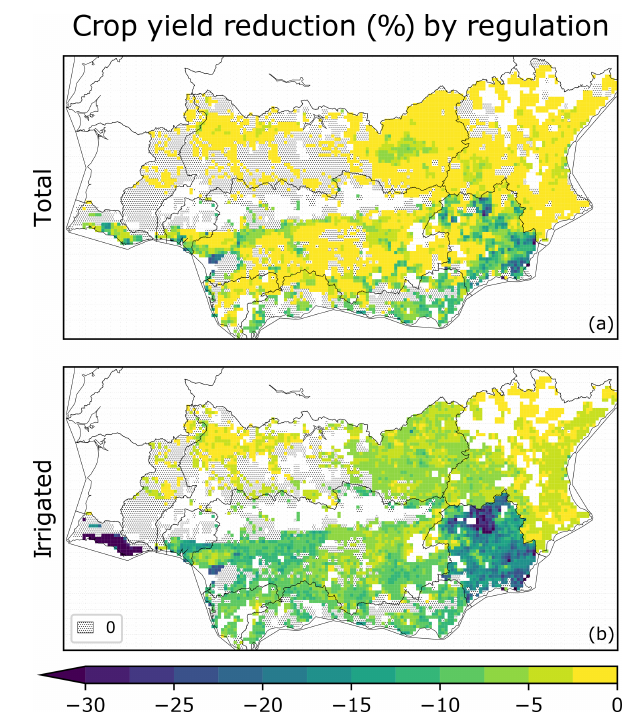
Figure 8. Estimated reduction of crop yield caused by the restric- tion of groundwater irrigation abstraction to sustainable levels in the southern Iberian Peninsula: total (a) and irrigated (b) crop yield. Displayed reductions are 1990–2018 weighted averages, using cul- tivated areas of modelled crop types as weights.